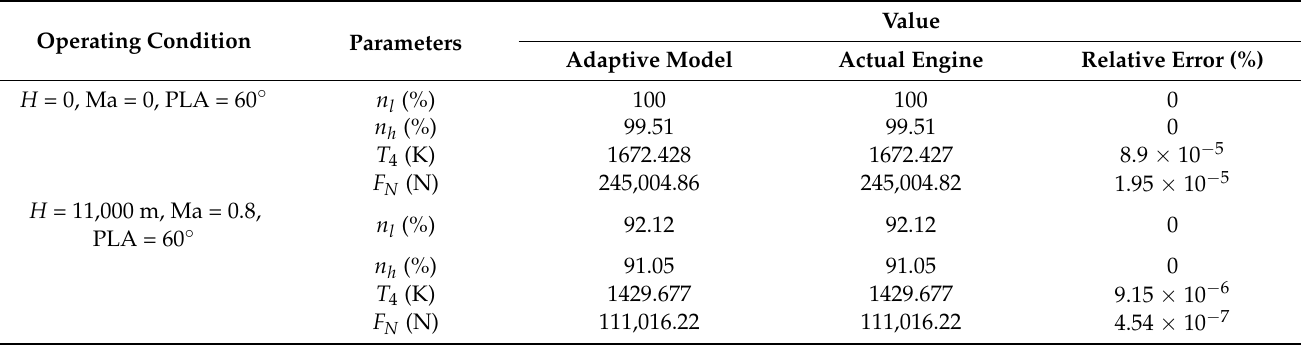
Table 4. Simulation and comparison results at single